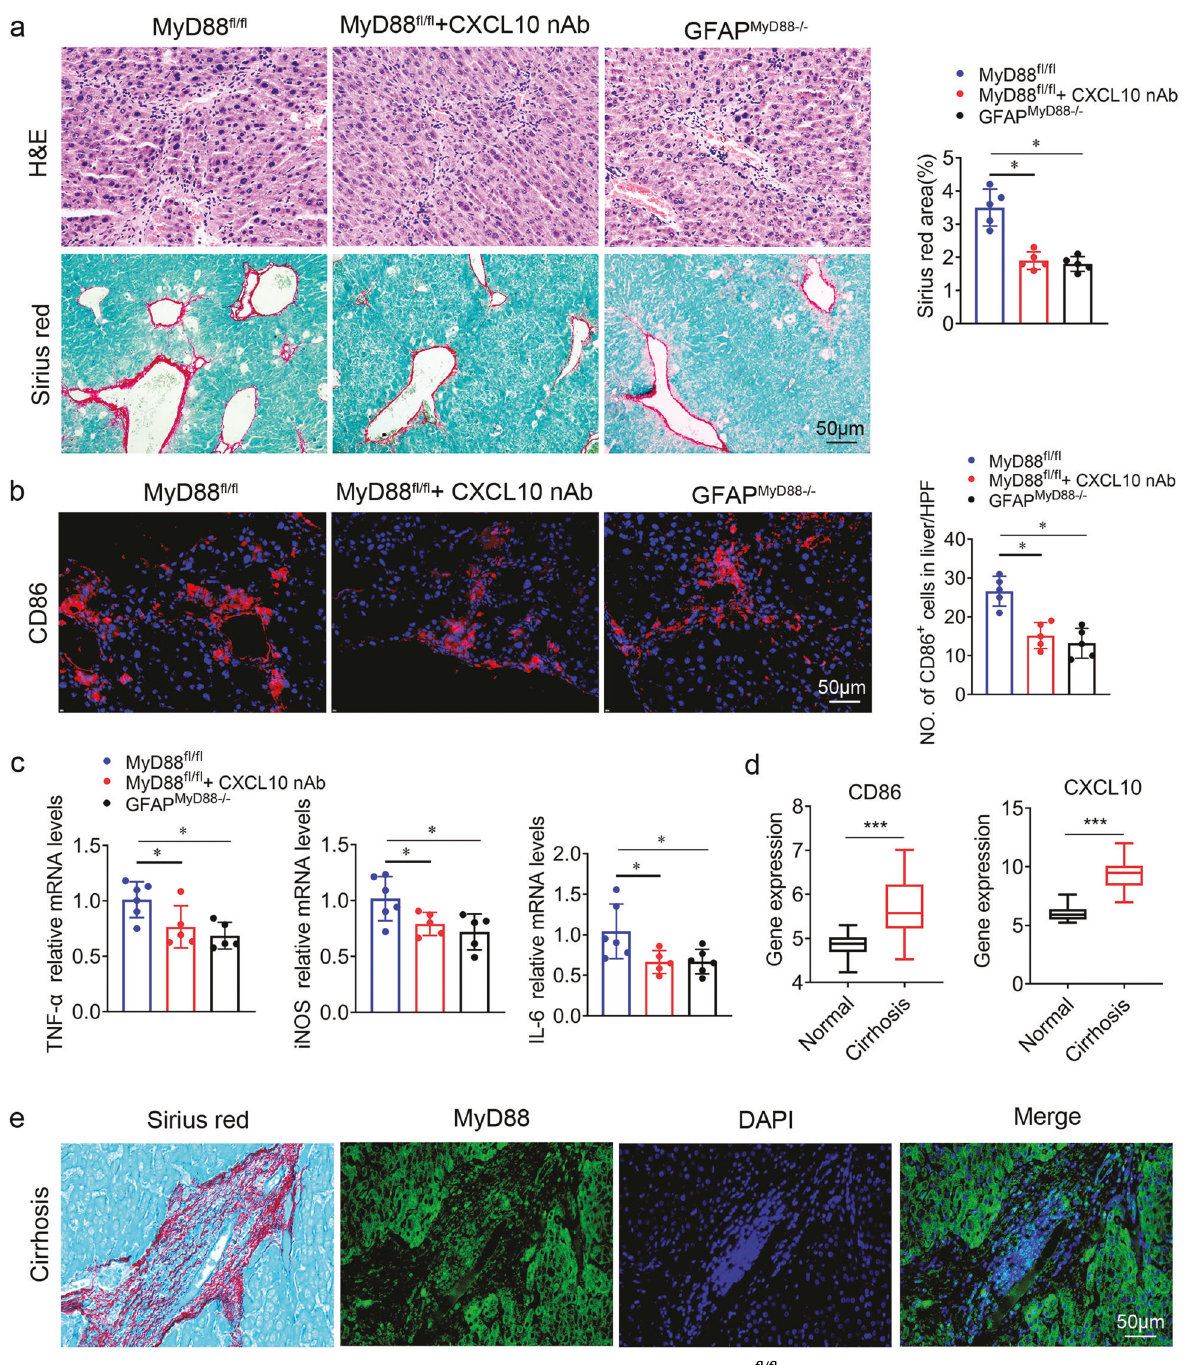
Fig. 7 Anti-CXCL10 treatment attenuates CCl 4 -induced liver fi brosis. Groups of MyD88 fl / fl mice ( n = 5 per group) were treated with CCl 4 and anti-CXCL10 mAb or mIgG twice a week for 2 weeks. GFAP MyD88 − / − mice were injected with CCl 4 at the same time. These charts show the average of the experimental results, with the error bar showing the standard error of mean. a H&E and Sirius red staining of liver tissues. Scale bar, 50 μ m. * p < 0.05. b immuno fl uorescence staining of CD86 in liver tissues. Scale bar, 50 μ m, * p < 0.05. c The mRNA levels of IL-6 and iNOS in LX-2 cells were detected by qPCR, * p < 0.05. d Analysis of CXCL10 and CD86 expression in clinical samples from normal and cirrhosis patients in the GSE14323 database. Differences were analyzed by the log-rank test. *** p < 0.001. e Consecutive sections of liver tissues of cirrhosis patients for Sirius red and MyD88 immuno fl uorescence